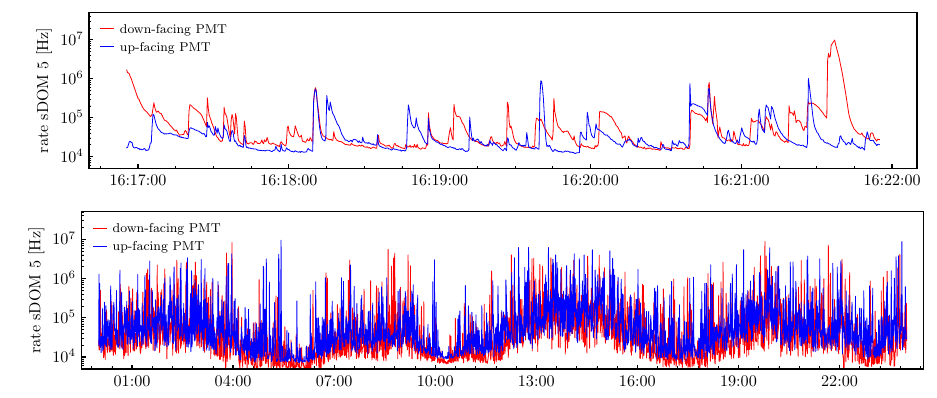
Figure 3. Dark rate of sDOM #5 deployed at a depth of 2.6km at the Cascadia Basin. The plots show a short term (top) and a long term (bottom) monitoring of the PMT dark rate in Hertz with respect to UTC time. Both time profiles show distinct structural features which are subject to further investigation. Adapted